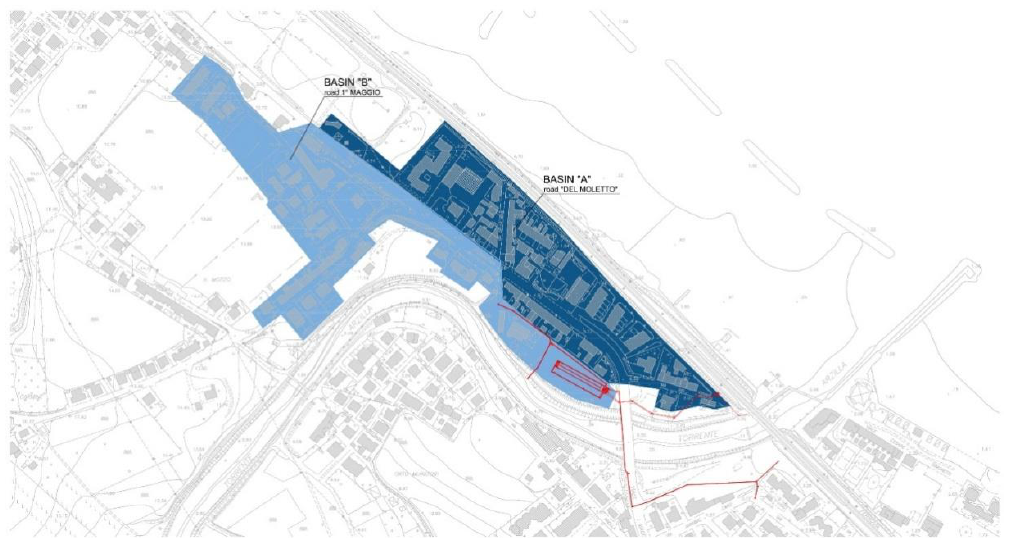
Figure 2. The two sewer catchments .